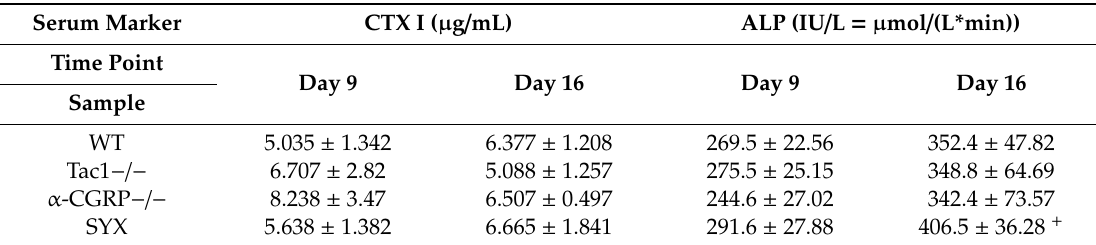
Table 1. Serum analysis of bone resorption marker CTX I and bone formation marker ALP. CTX I